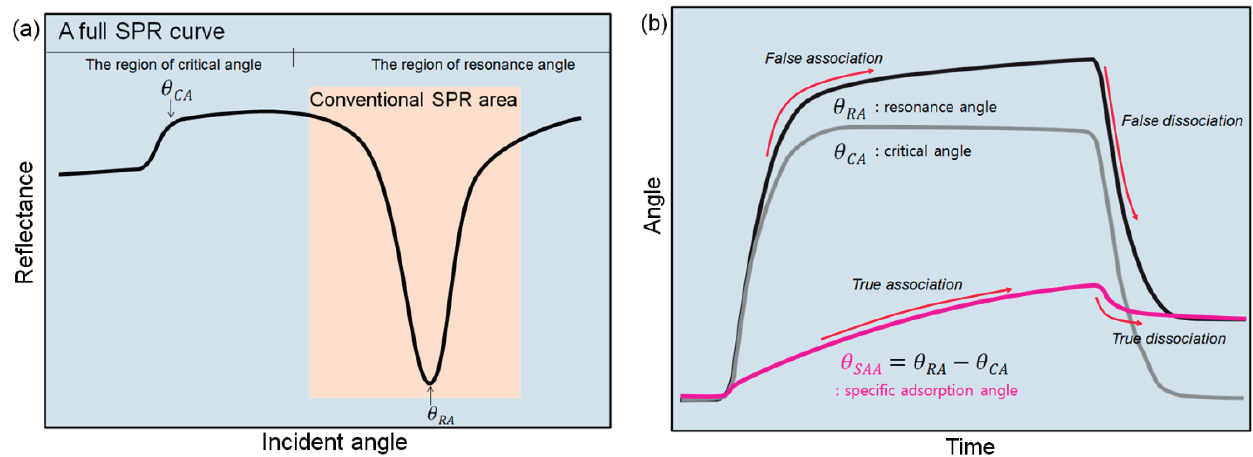
Figure 1. Concept schemes of the proposed sigmoid-asymmetric fitting method: ( a ) A full SPR curve including both regions with critical angle and resonance angle. ( b ) Sensor grams indicating the changes in resonance angle, critical angle and specific adsorption angle, respectively. Our novel method can monitor the change in the specific adsorption angle ( (cid:2016) ) by simultaneously monitoring the change in the resonance angle ( (cid:2016) (cid:3020)(cid:3002)(cid:3002) the change in the critical angle ( (cid:2016) ) (cid:3004)(cid:3002)